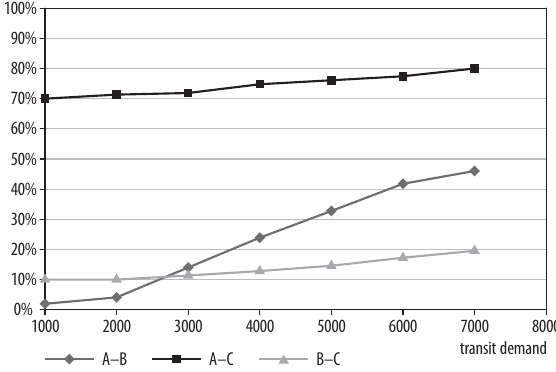
Fig. 2. Th e percentage of passengers using intercity bus with diff erent levels of transit demand